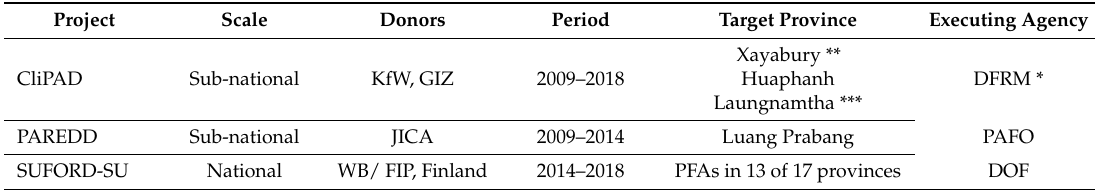
Table 1. Overview of three selected pilot projects.